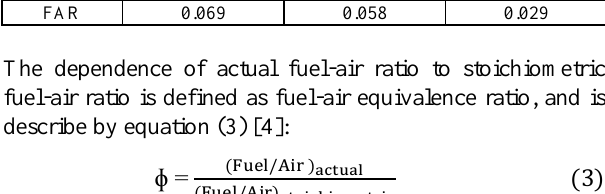
Table 2. Stoichiometric FAR for selected fuels